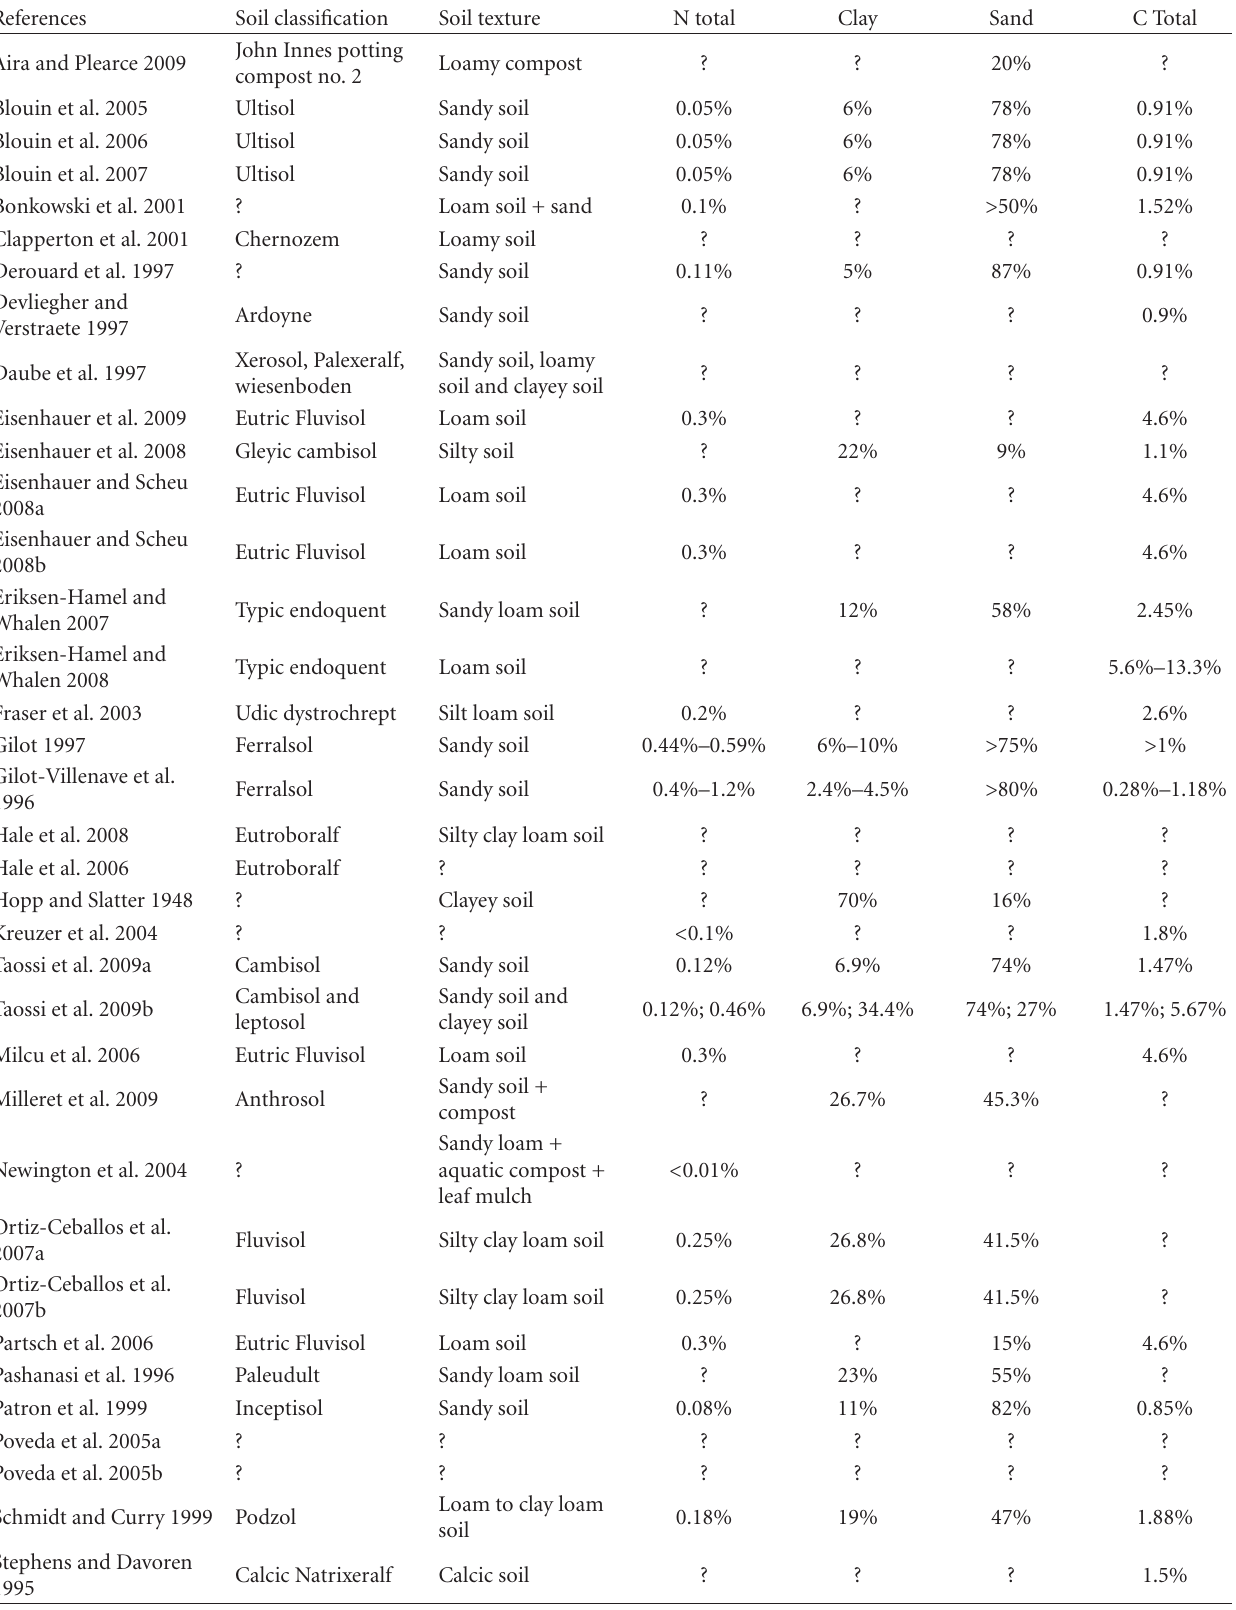
Table 1: References included in the survey of C and N contents in soil and the soil texture used in earthworm e ff ects on plant